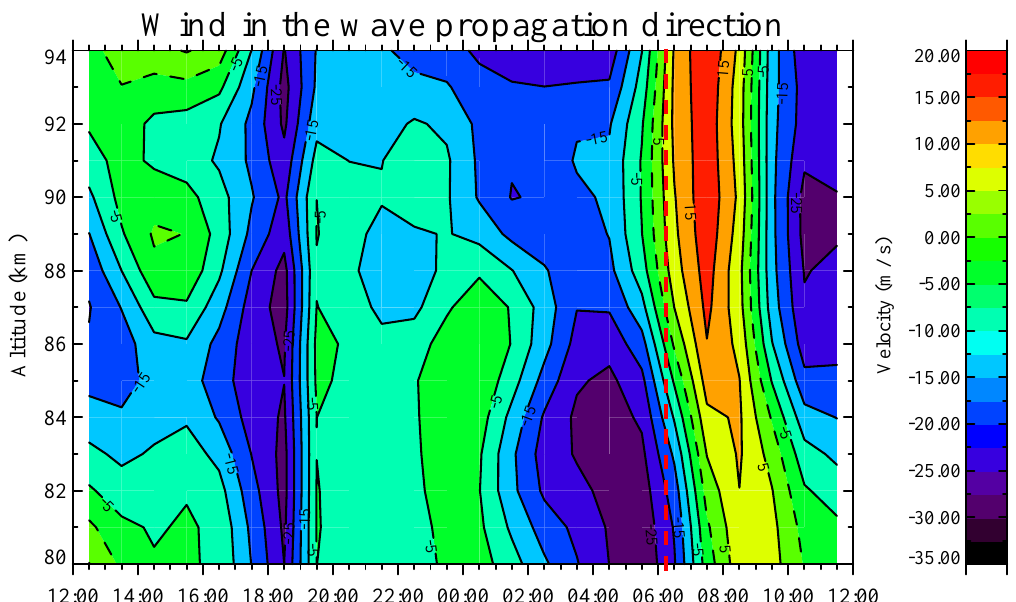
Fig. 5. Contour plots of wind in the wave propagation direction.